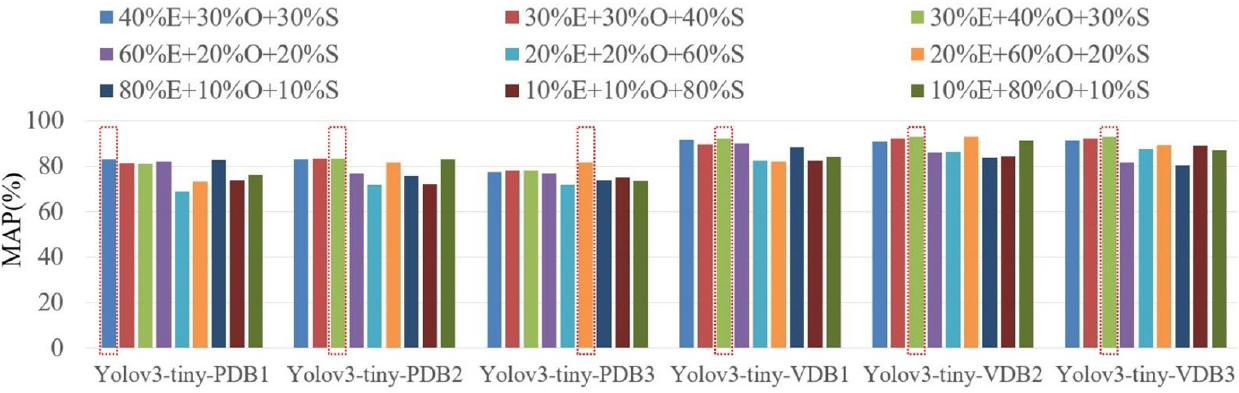
Figure 8. Evaluation results using different proportions of various imaging quality data.